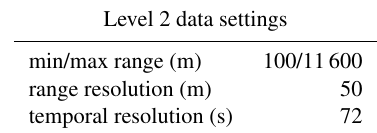
Table 5. General specifications of the level 2 dataset.